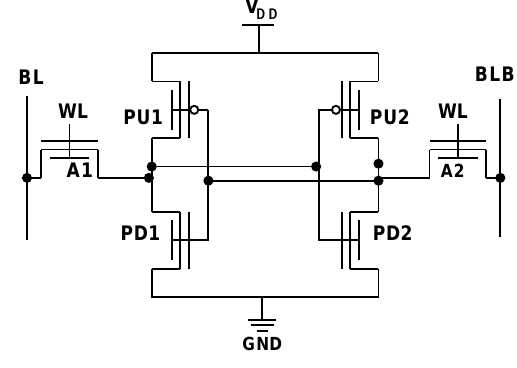
Figure 2. 6T SRAM